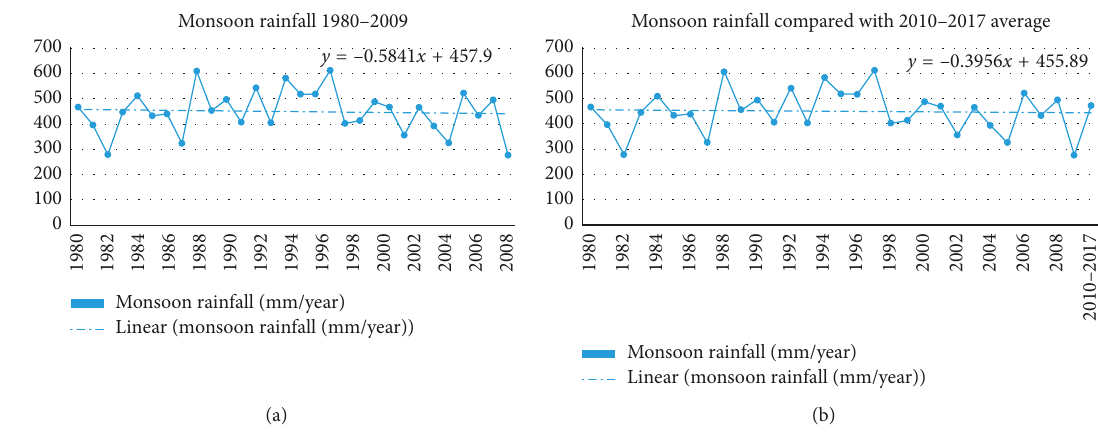
y = –0.5841 x + 457.9